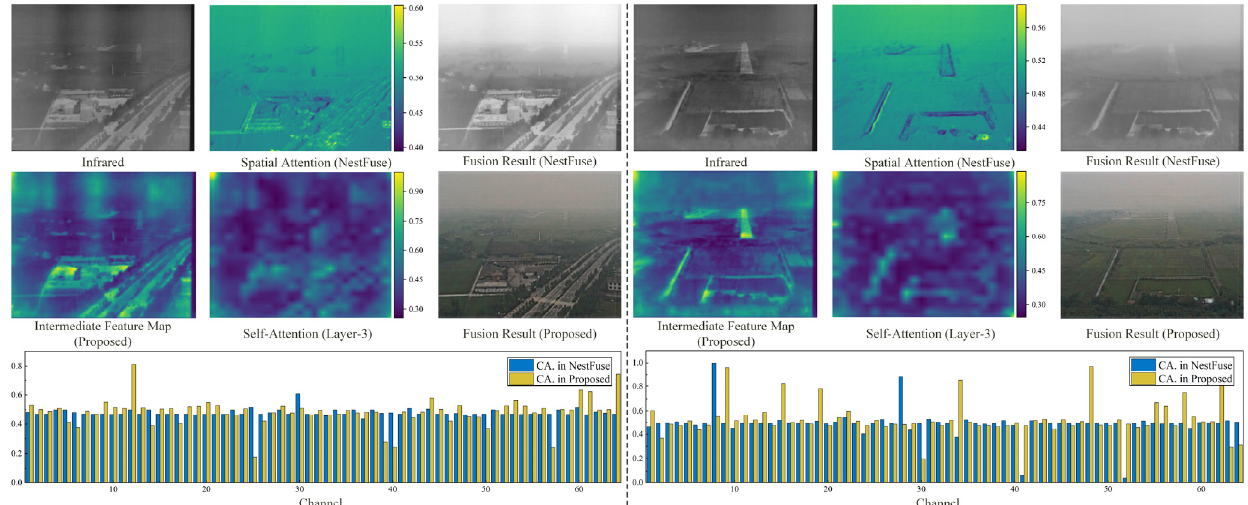
Figure 10. Comparison of attention mechanisms (NestFuse and the proposed fusion; the histogram represents the channel weight of the visible branch with the corresponding input pair).